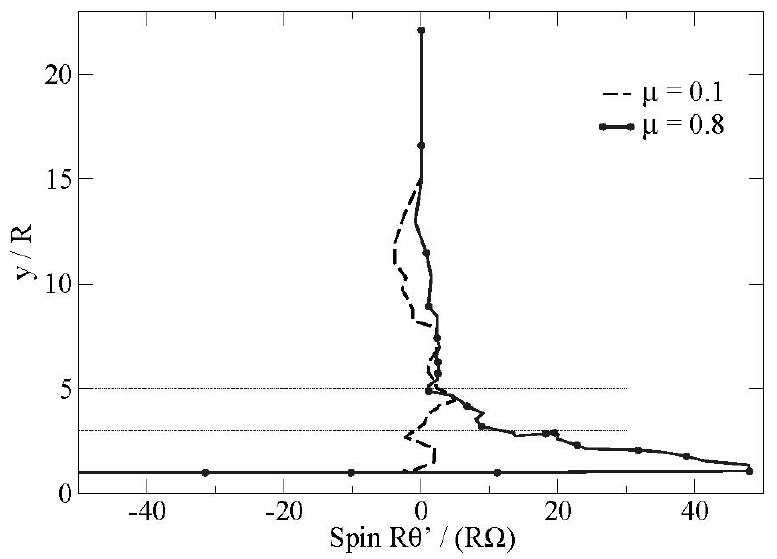
Figure 6. Evolution of the angular velocity of a particle in the flow for different friction coefficients at the boundary ( μ = 0.1–0.8).